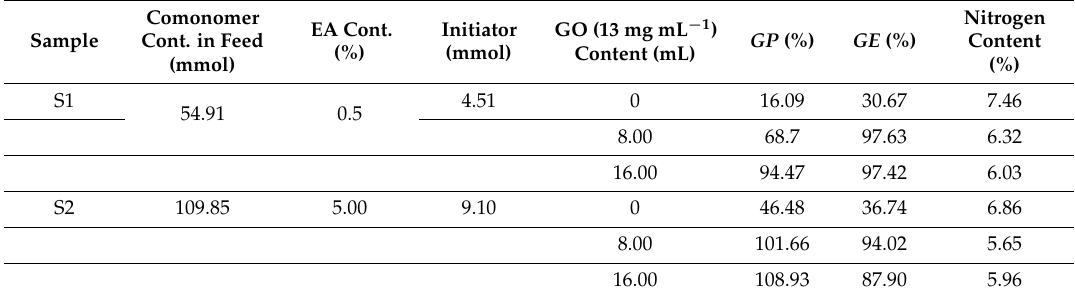
Table 1. The effect of graphene oxide (GO) contents on grafting